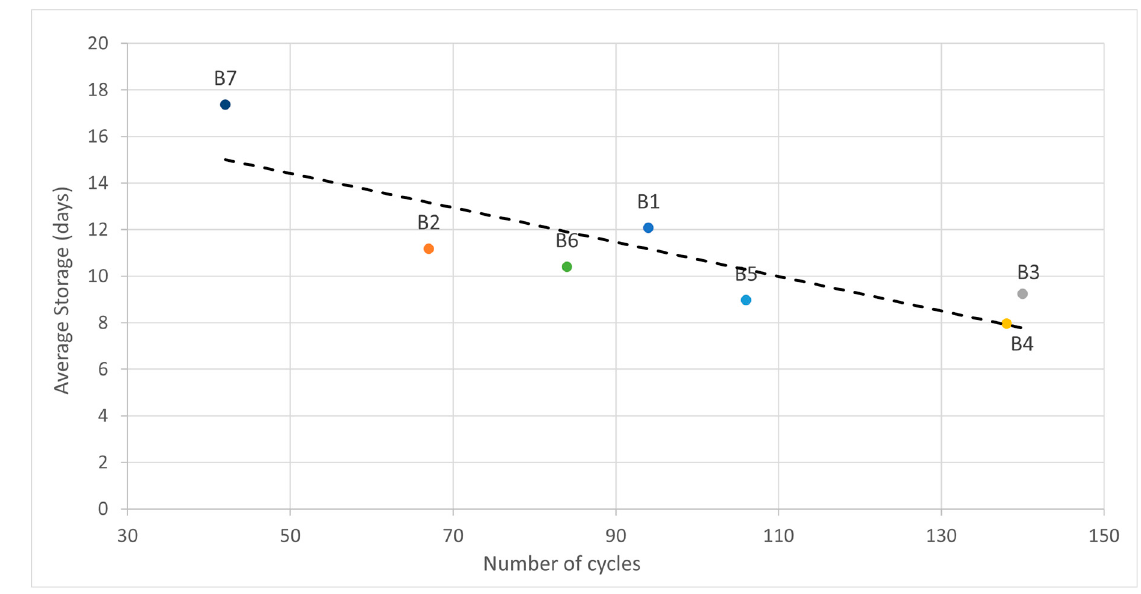
Figure 15. Average storage time vs. cycle life.